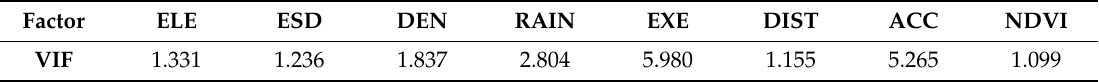
Figure 17. correlation coefficient matrix. Table 4. Variance inflation factor after factor